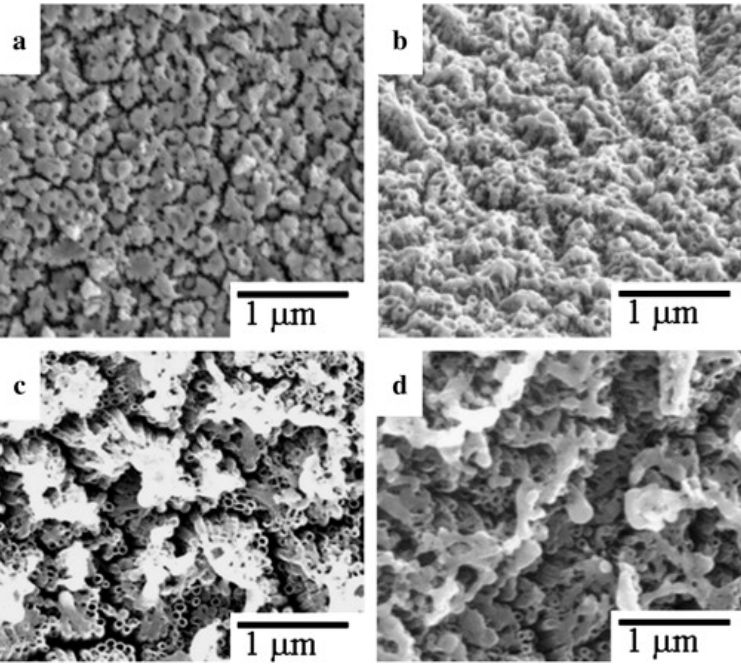
Figure 9. Surface of titania nanotubes irradiated with 9000 bursts at 125 mJ/cm 2 at a 0° ( a ), 30° ( b ), 75° ( c ), and 85° angle ( d ). Reprinted with permission from [57].